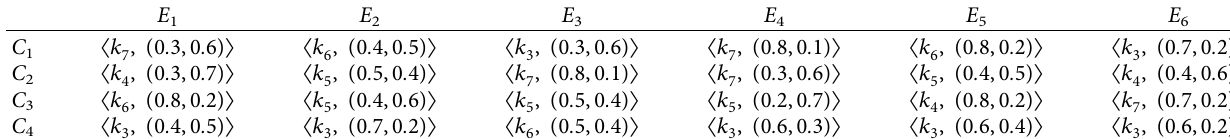
Table 5: Intuitionistic linguistic matrix-expert 3.